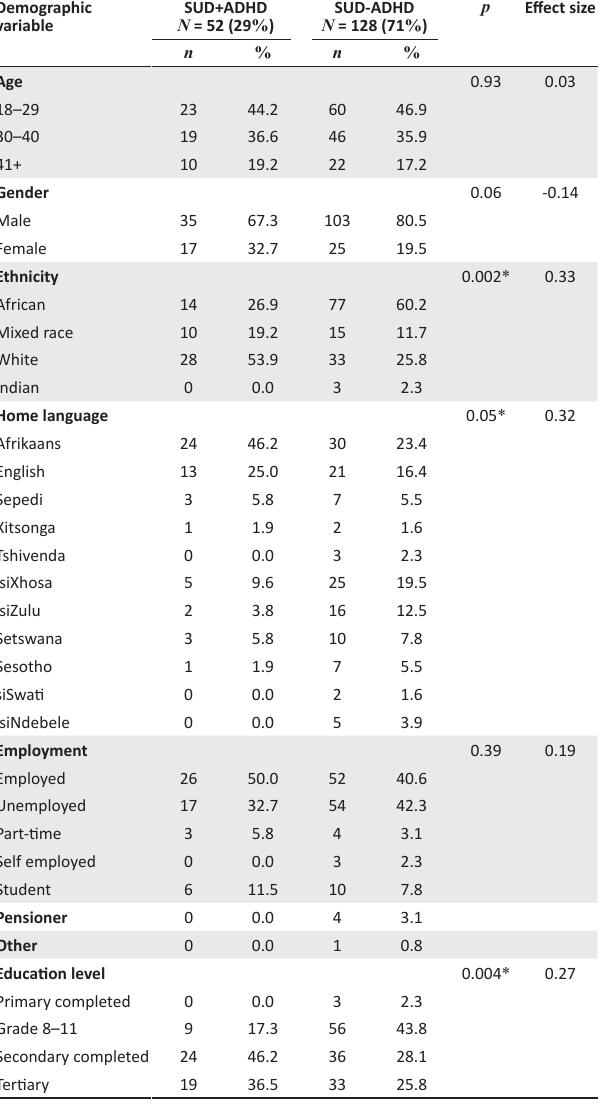
TABLE 1: Demographics of the sample. Demographic